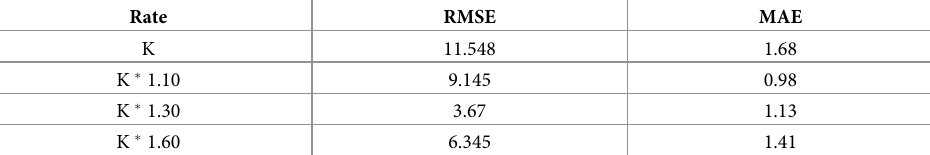
Table 4. Impact analysis of population size S 0 .